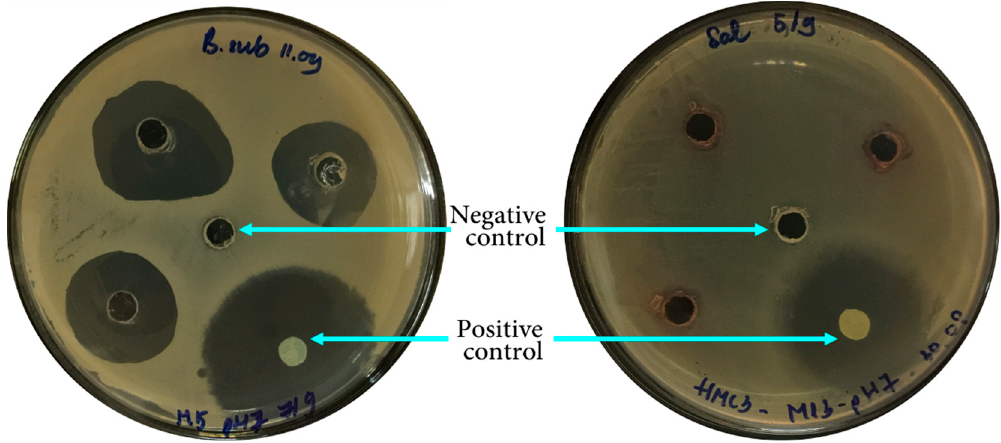
Figure 3. An example of plates tested for sponge-associated bacteria.